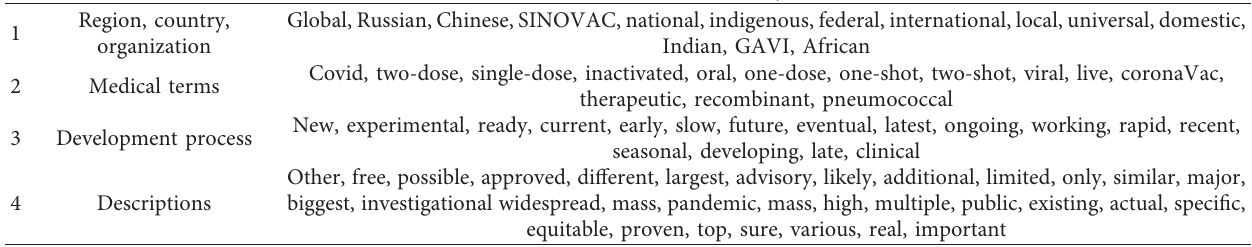
Table 4: The classification of neutral adjectives.